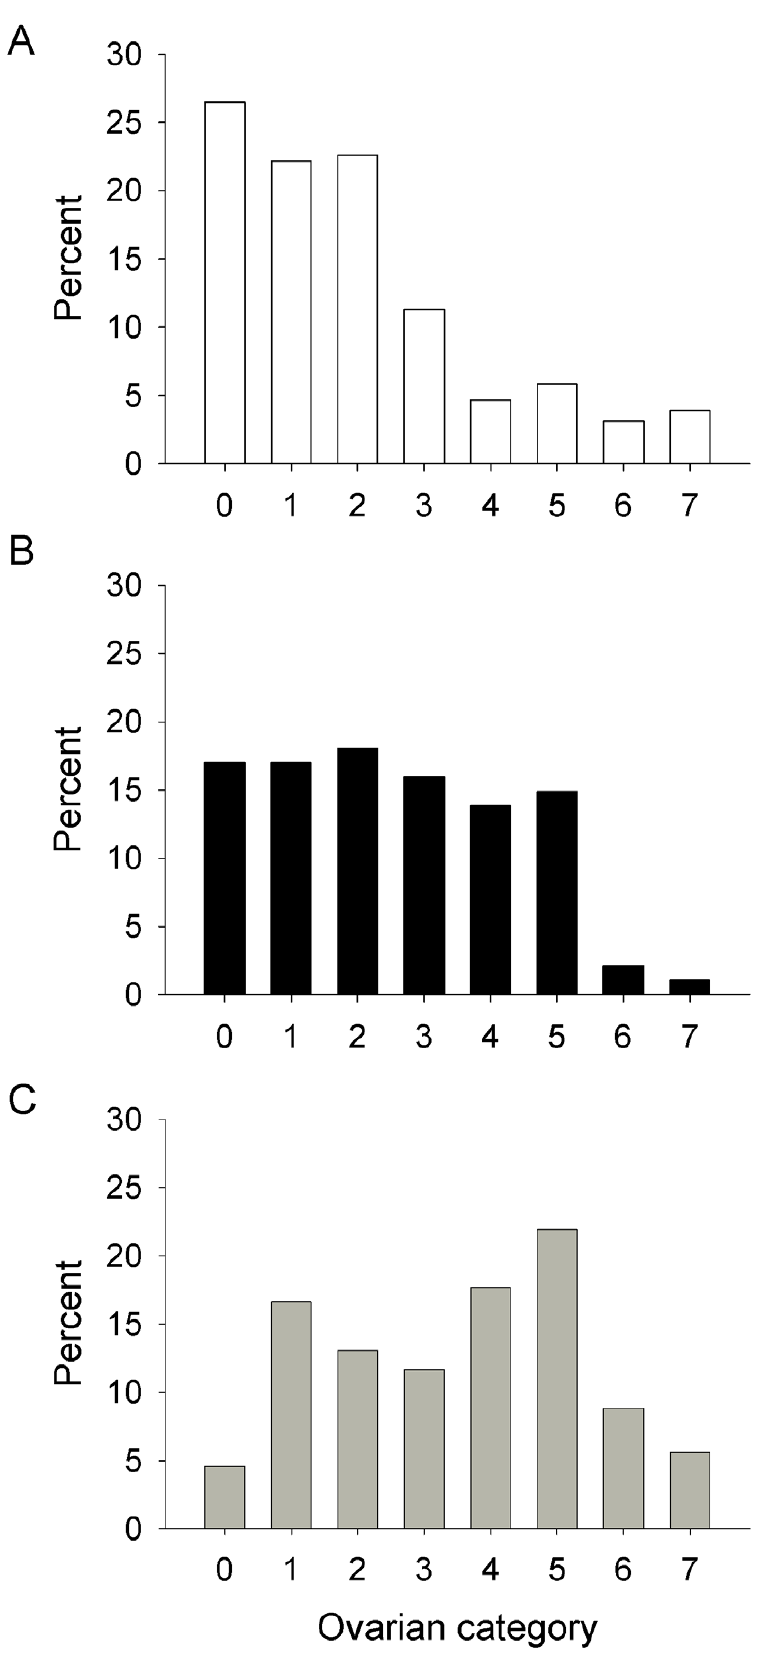
Figure 2. Ovarian categories of female G.m.morsitans from (A) men, (B) ox and (C) traps. Percent distribution of ovarian categories of female G. m. morsitans from (A) men, (B) ox and (C) traps. Sample sizes of 257, 94 and 283 for men, ox and traps, respectively. doi:10.1371/journal.pntd.0001791.g002 PLOS Neglected Tropical Diseases |